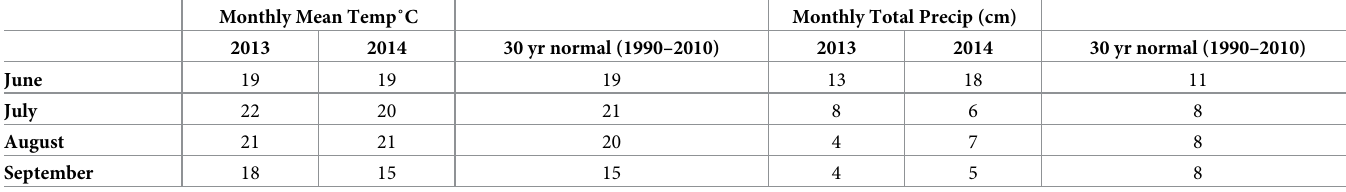
Table 3. Monthly temperature and precipitation averages with 30-year normal over 2013 and 2014 growing